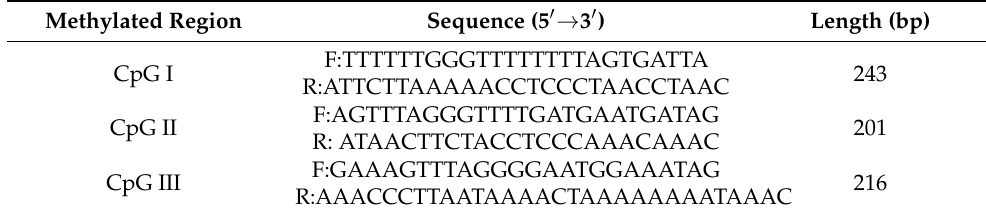
Table 12. BSP primers for rabbit KRT17